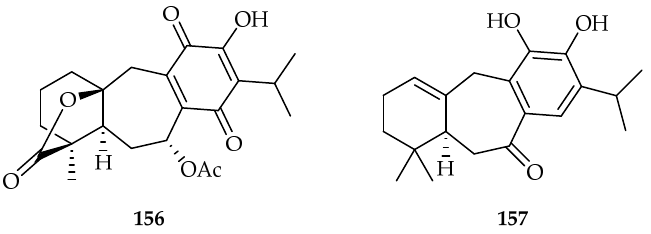
Figure 64. Structure of compound 156 [101] and salviadenone A 157 [102].